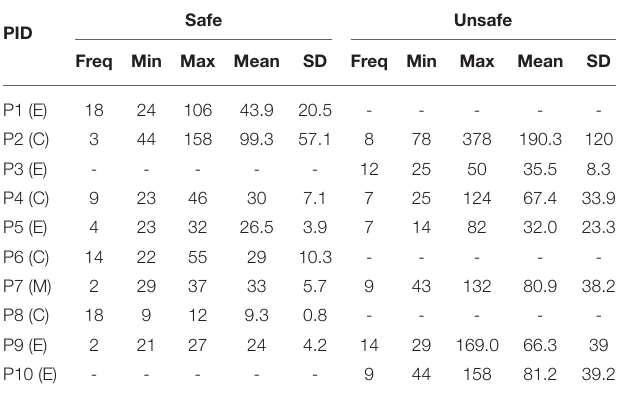
TABLE 9 | Frequency, minimum, maximum, mean, and standard deviation (SD) of the number of moves in human user solutions for the Rush Hour planning tasks P1 through